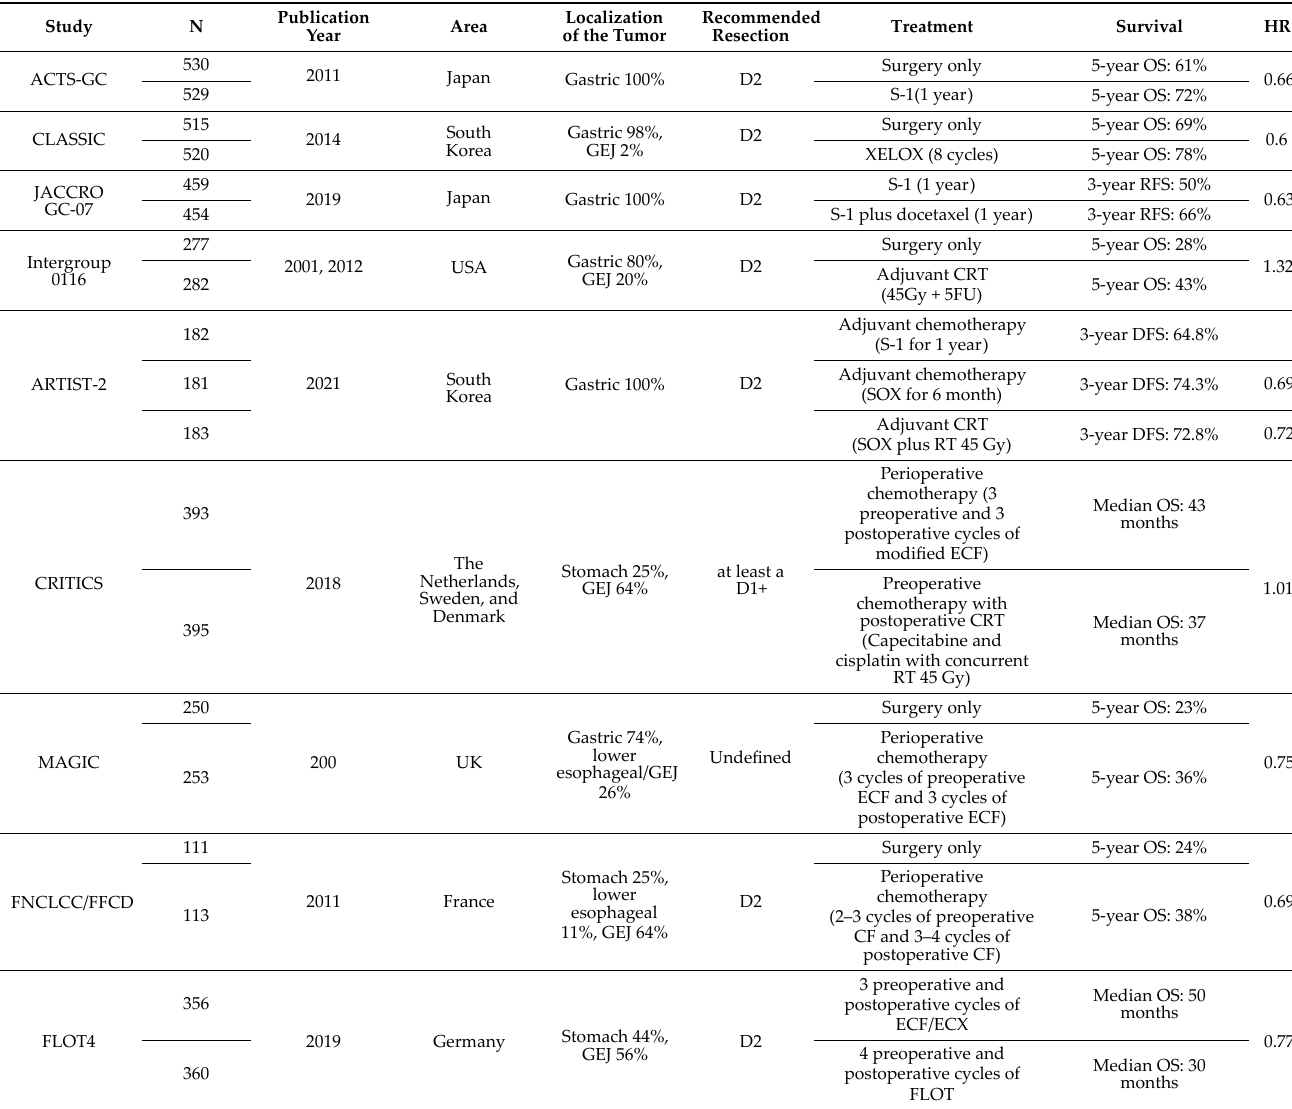
Table 4. Pivotal randomized controlled clinical trial of perioperative (neoadjuvant) and adjuvant therapy for gastric